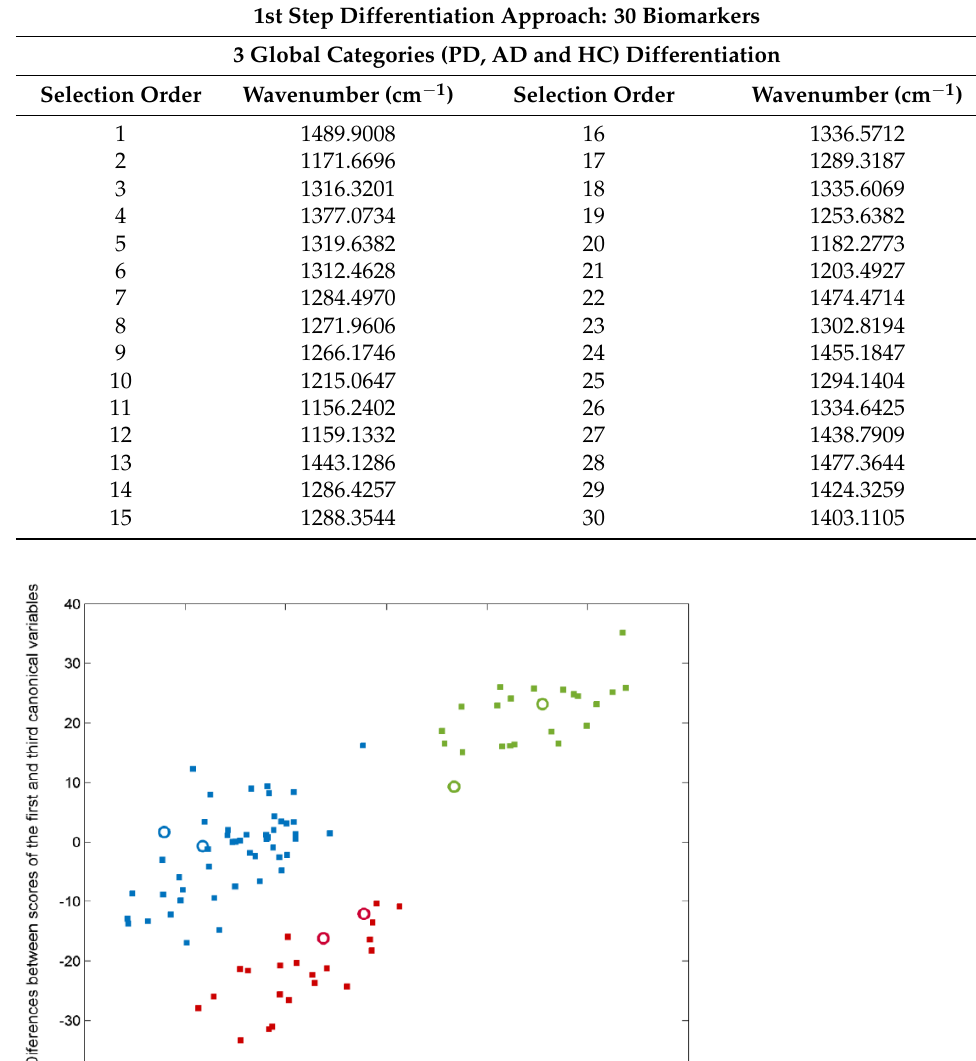
Table 2. Discriminant wavenumbers (in order of selection) corresponding to the SELECT-LDA classification developed from IR spectra of plasma samples in the global approach.